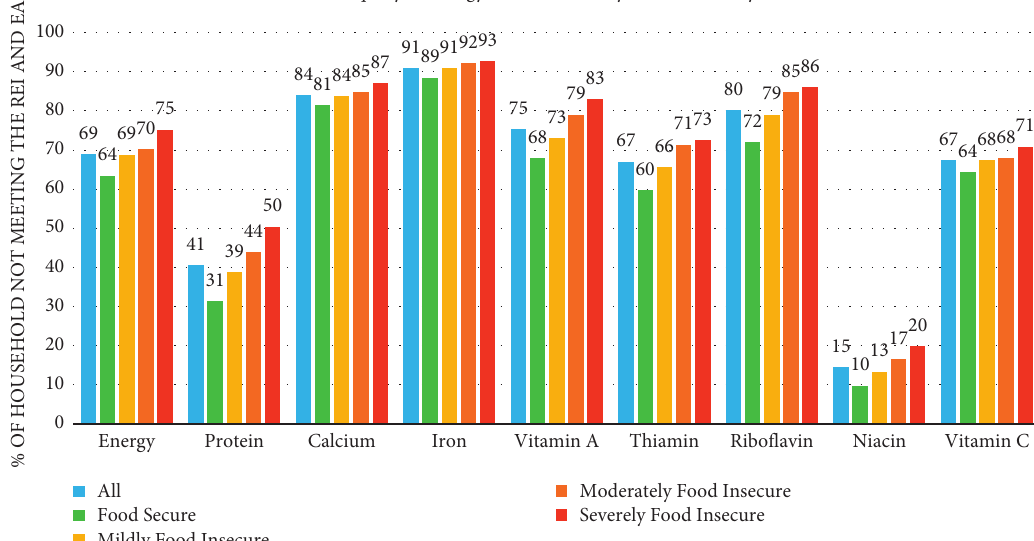
Figure 1: Proportion of households with inadequate energy and nutrient intake not meeting 100% REI and EAR intake by the food security level. Table 8: Household food security by household food consumption classification.